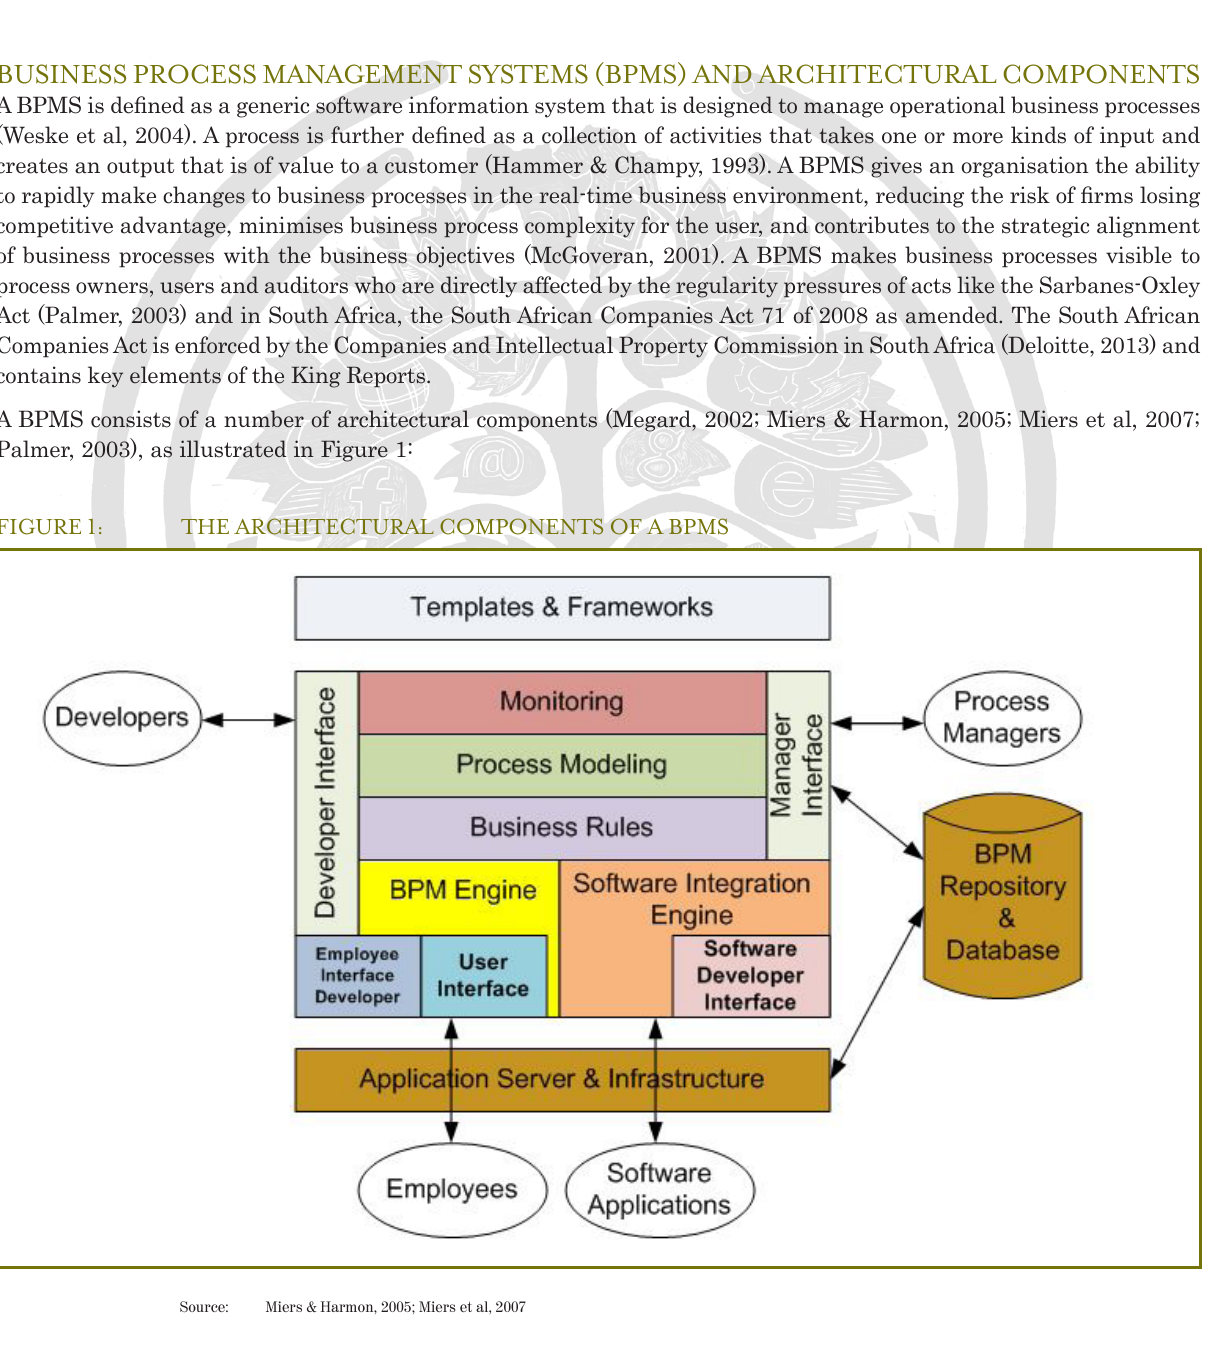
Source: Miers & Harmon, 2005; Miers et al,